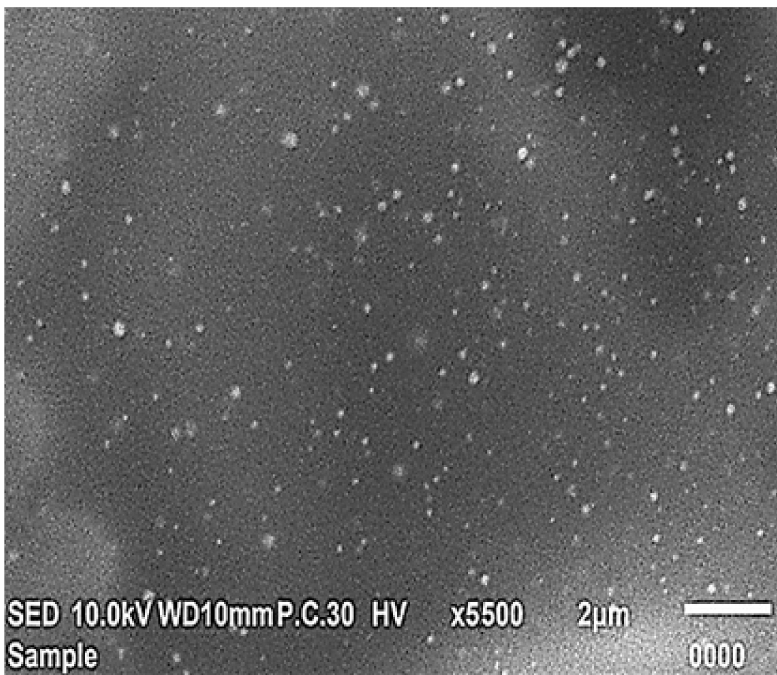
Figure 11. Scanning electron micrograph of the optimized EGCG-loaded nanospanlastic formula (F4). Abbreviation: EGCG, epigallocatechin gallate.